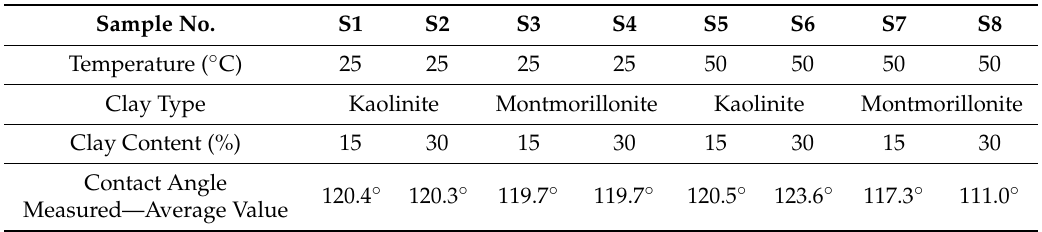
Table 5. Contact angle values of oil-wet sandstone samples.